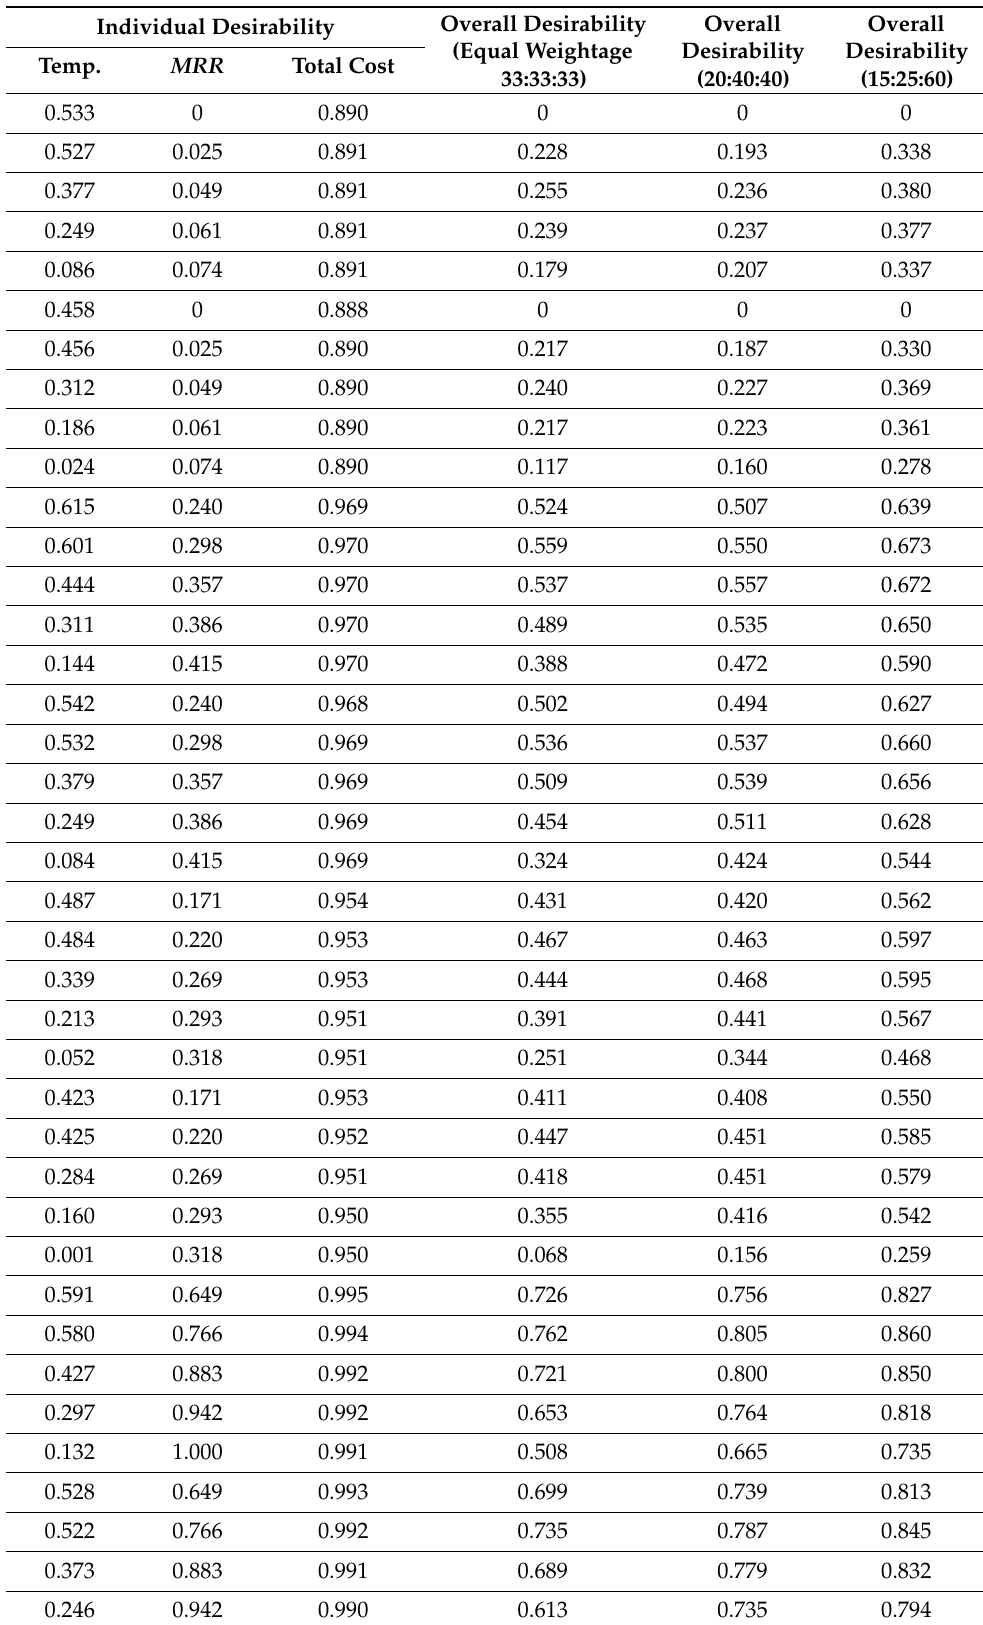
Table 7. Individual and overall desirability values for three different